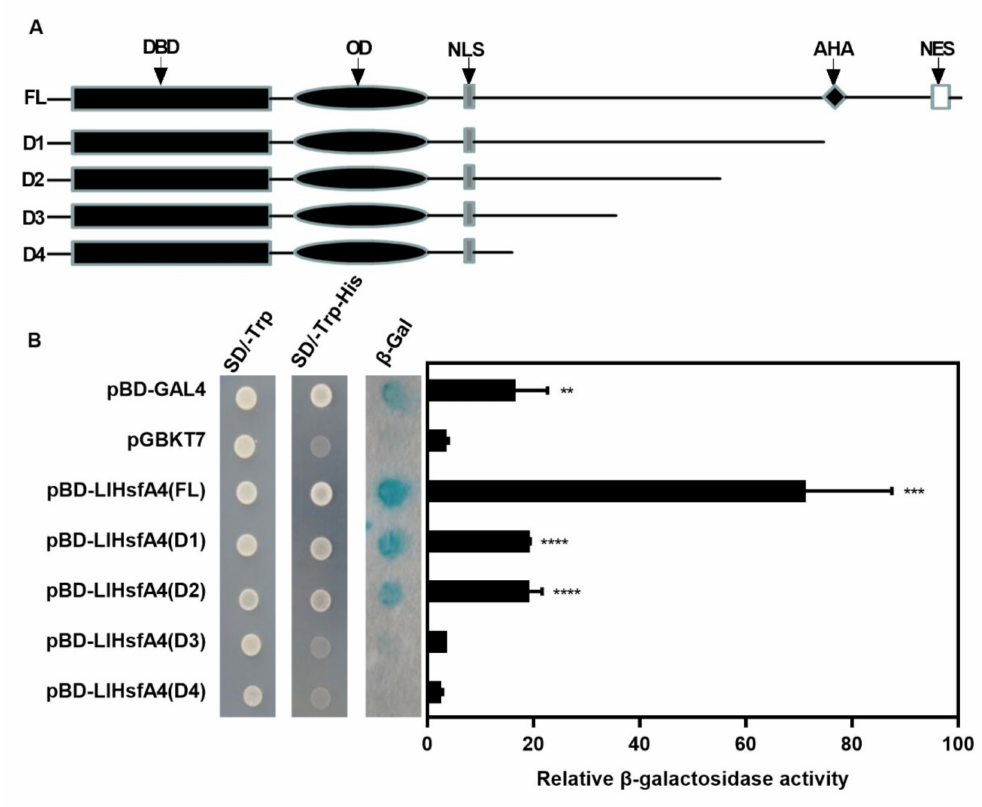
Figure 5. Transactivation activity of LlHsfA4 in the yeast strain AH109. ( A ) Different deletion forms of LlHsfA4 were constructed for the transcriptional activation assay. ( B ) Transactivation activity of different constructs were examined in yeast and the β -galactosidase activity of the transformed yeast cells was detected and measured. The transformed yeast cells were grown in a SD medium with or without histidine and X-gal staining was used for detecting β -gal activity. β -gal activity was measured through an enzyme assay. Three independent experiments were performed, each with three technical replicates, showing one experiment result. T-test analysis of variance was employed to identify treatment means that differed statistically. Samples with different letters are significantly different: ** p < 0.01, *** p < 0.001, **** p < 0.0001, Unmarked means